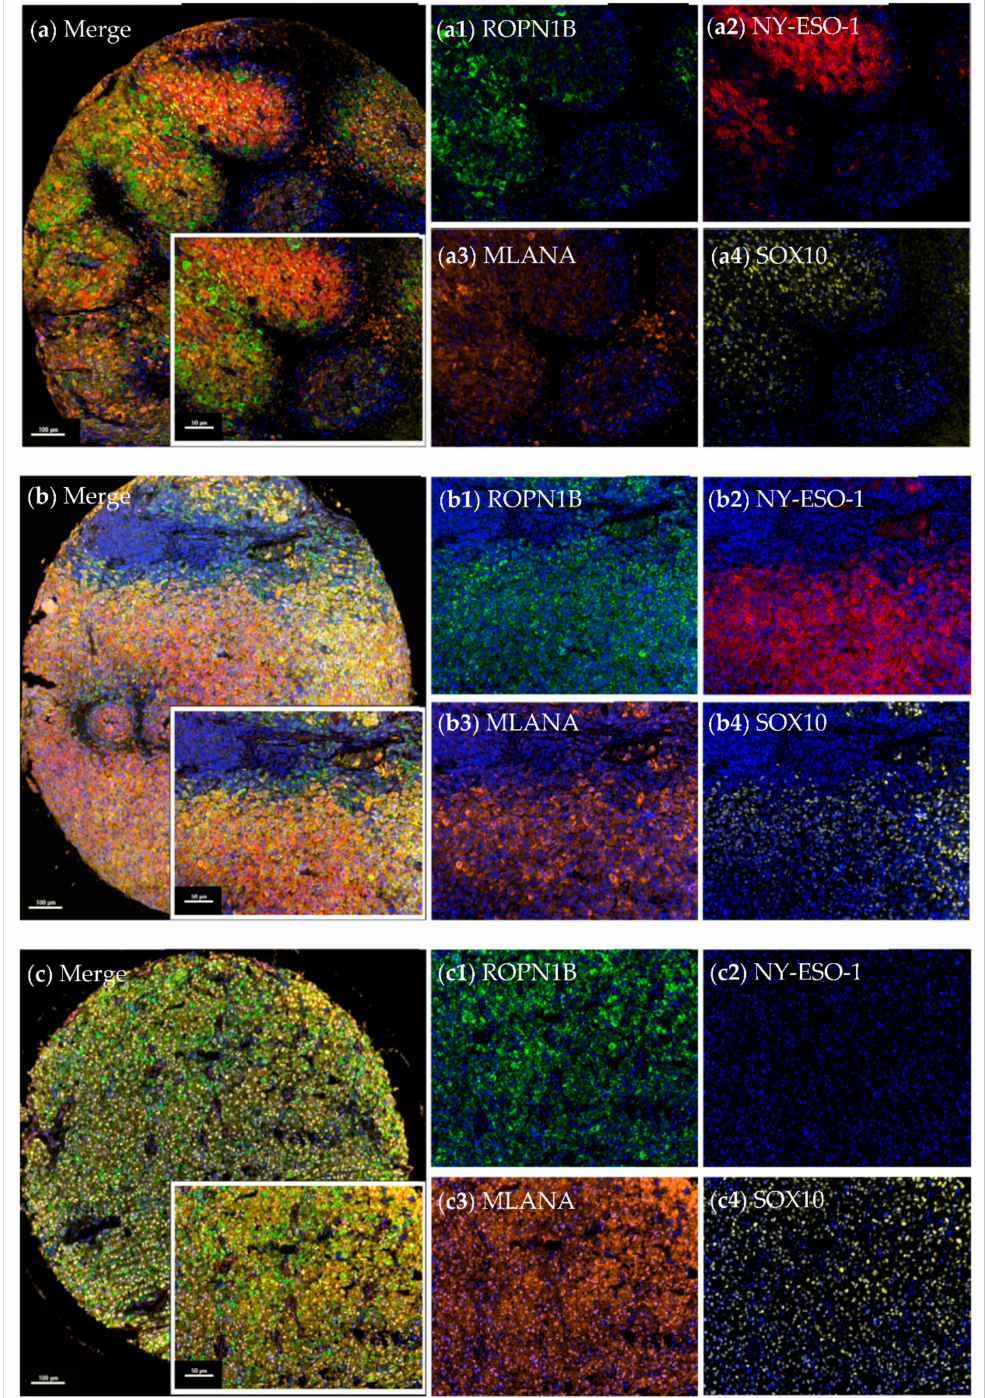
Figure 2. Patterns of ROPN1B and NY-ESO-1 expression in melanoma tumours. Multispectral immunohistochemistry of melanoma tumour cores showing staining for ROPN1B, NY-ESO-1, MLANA and SOX10. Representative cores showing ROPN1B and NY-ESO-1 co-expression in discreet ( a ) or shared ( b ) tumour regions, as well as exclusive ( c ) ROPN1B expression. Tissue microarrays were stained with anti-ROPN1B (green), anti-NY-ESO-1 (red), anti-MLANA (orange) and anti-SOX10 (yellow) antibodies with DAPI (blue) counterstain, and are displayed as merge ( a , b , c ) and single colour ( a1 – a4 , b1 – b4 , c1 – c4 ) cores. Whole tumour cores with more than 2% of the tissue cells staining for the target proteins were considered positive. All images were taken using a 20 × objective, and scale bars indicate 100 µ m (core) or 50 µ m (region of